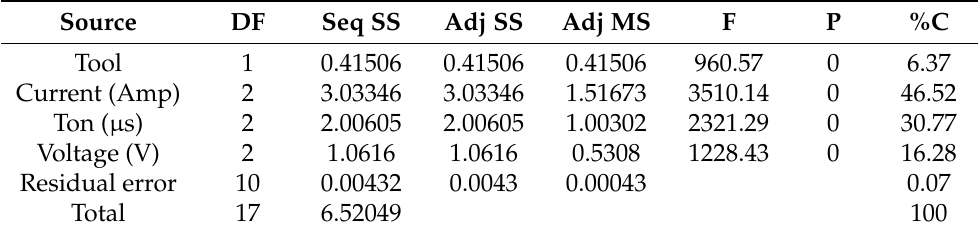
Table 7. Analysis of variance (ANOVA) for SR (R a